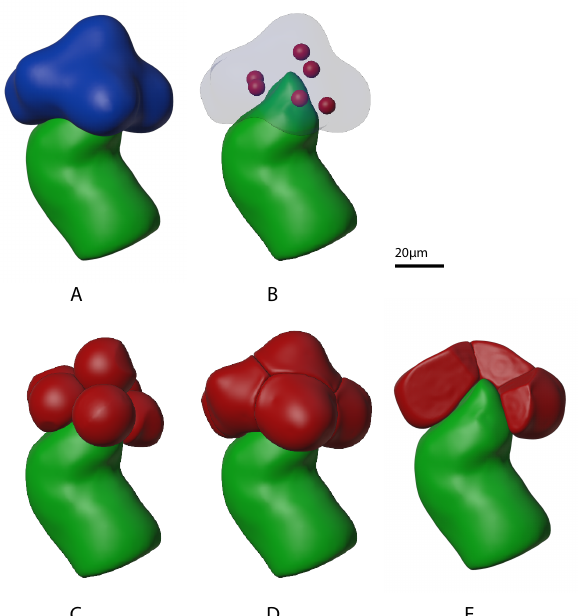
Figure 4. Progression of mini-gland individual acinus outer boundary “growth” stages. The mini- gland duct cell outer boundary from our prior work [27] is shown in green. ( Panel A ) shows the mini-gland acini outer boundary in blue. ( Panel B ) shows the arrangement of six individual acinus “seeds” in red. ( Panel C ) shows partially grown individual acini and ( Panel D ) shows the fully grown acini. ( Panel E ) shows the mini-gland with several of the acinus outer boundaries (red) removed. Note that the acini are packed tightly against each other as well as to the tip of the mini-gland duct outer